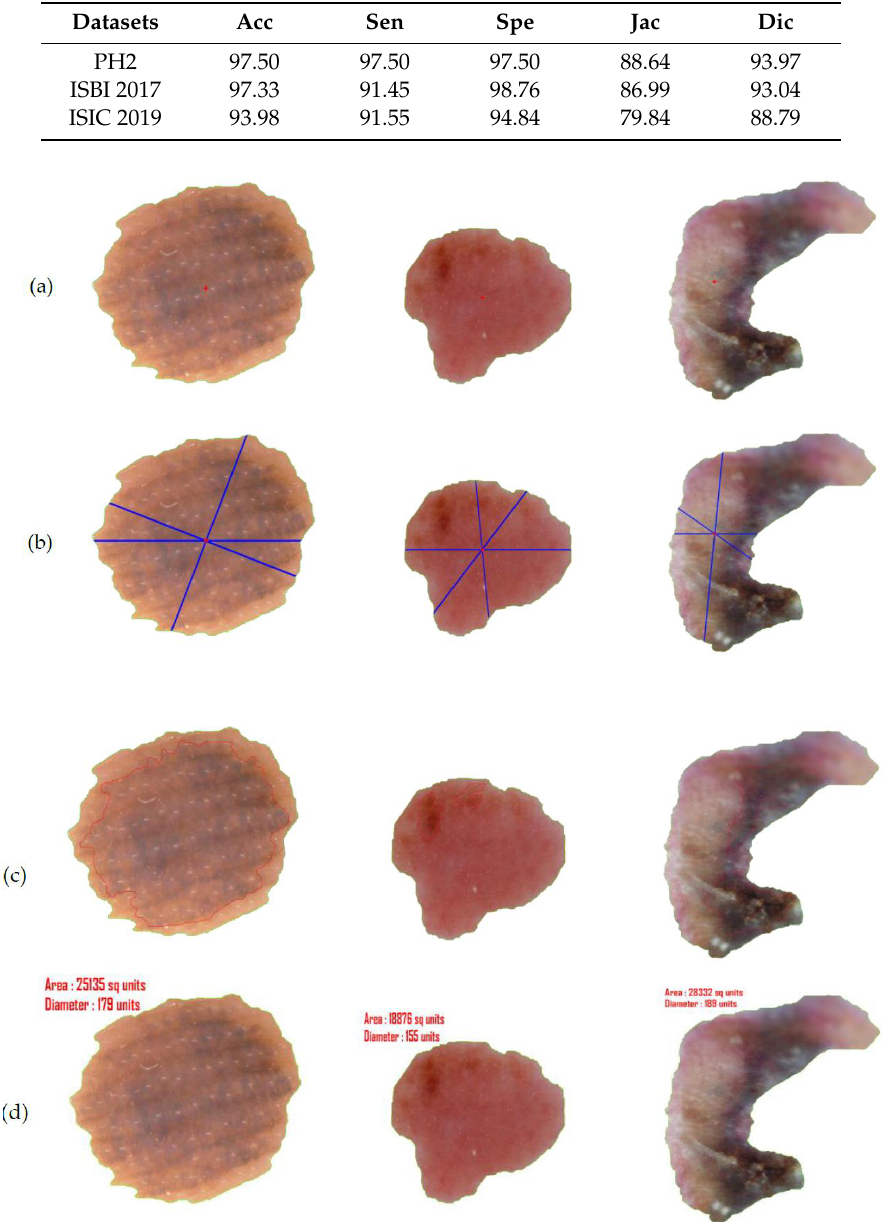
Figure 14. ( a ) Center point detection of the final segmented output, ( b ) asymmetry and border irregularity detection by calculating d ki and d kj , ( c ) the color variation detection and segregation on lesion images. ( d ) The derived measurement of diameter and area of the segmented lesion projected in ‘units’.